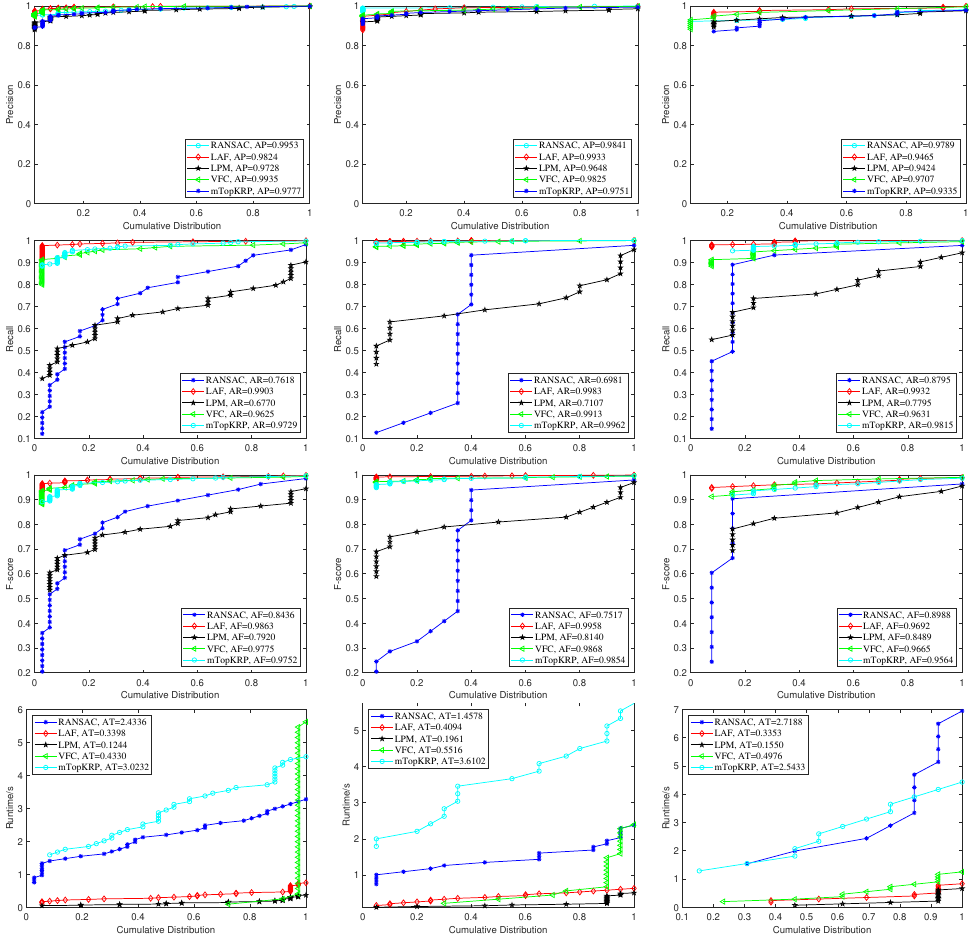
Figure 5. Quantitative comparisons of RANSAC [19], VFC [38], mTopKRP [23], LPM [21] and our LAF on on five image sets: (from ( left ) to ( right )) rigid (SAR, CIAP), projection (UAV) and nonrigid (FE). (( top ) to ( bottom )) Precision , Recall , F - score , and Runtime with respect to the cumulative distribution. The average Precision (AP), average Recall (AR), average F - score (AF), and average Runtime (AT) are reported in the